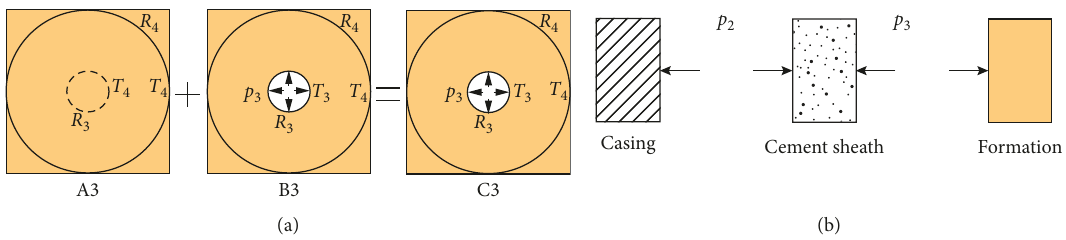
Figure 13: Thermal stress field. (a) Formation stress components. (b) Interface pressures. p casing-cement sheath interface and cement sheath-formation